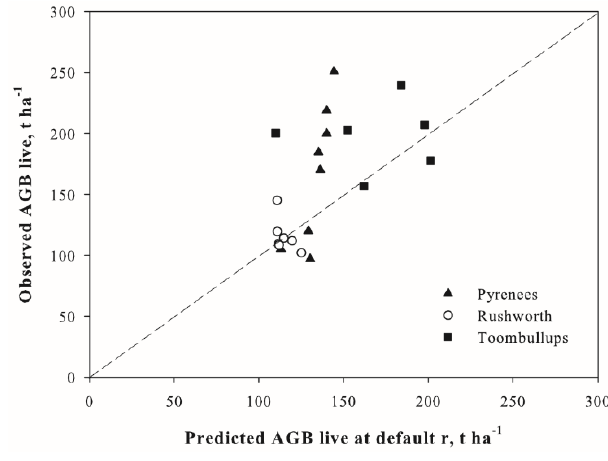
Figure 3. Observed vs. Full Carbon Accounting Model predicted aboveground live biomass in Eucalyptus open forests of SE Australia at default r